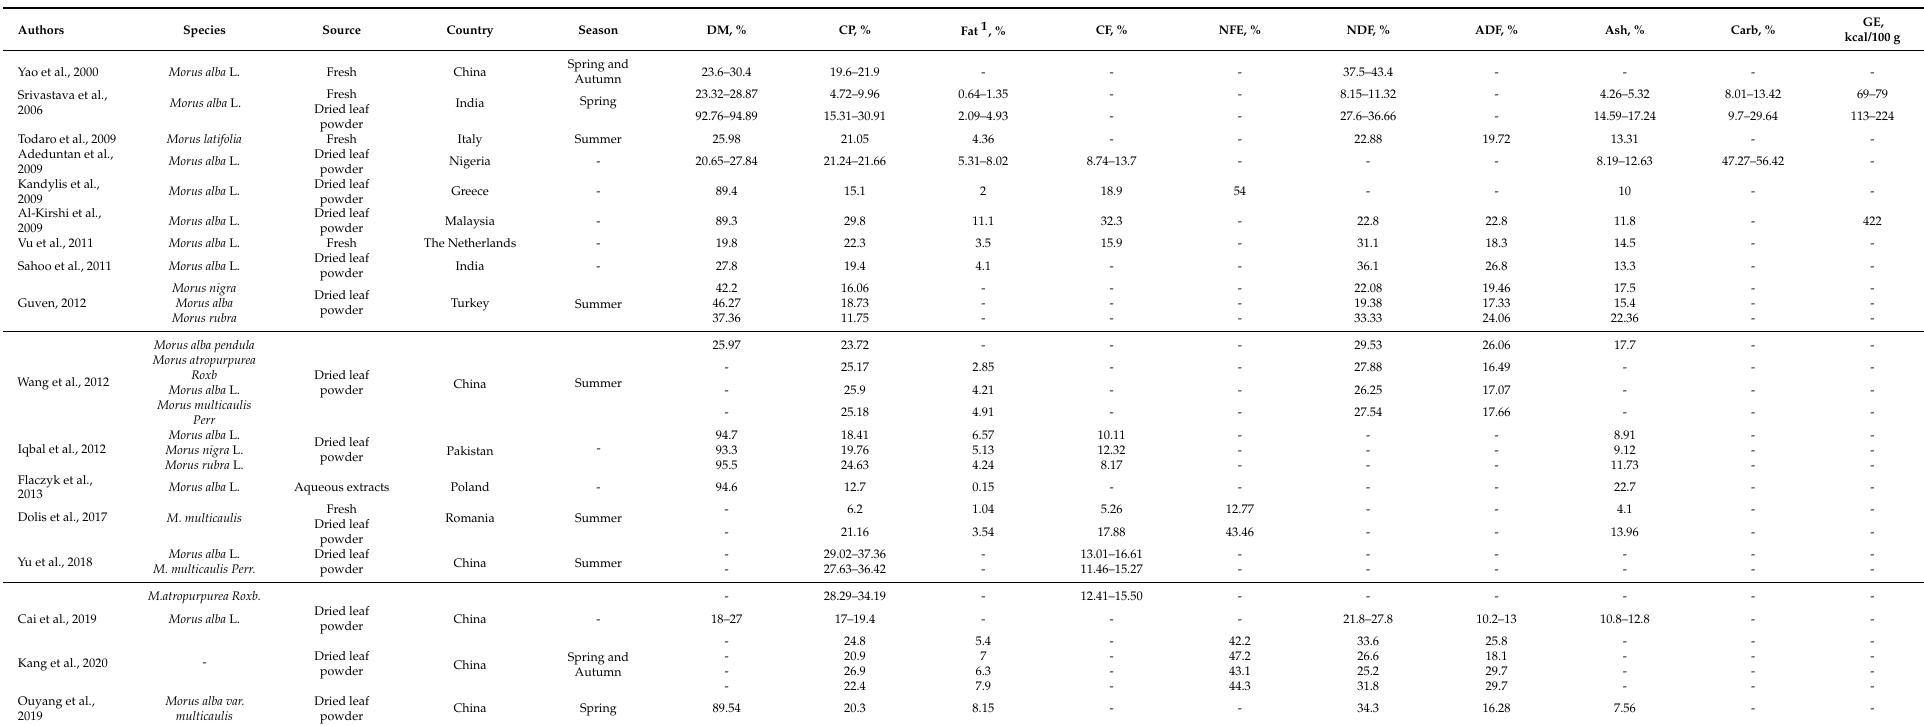
Table 1. Chemical composition of mulberry